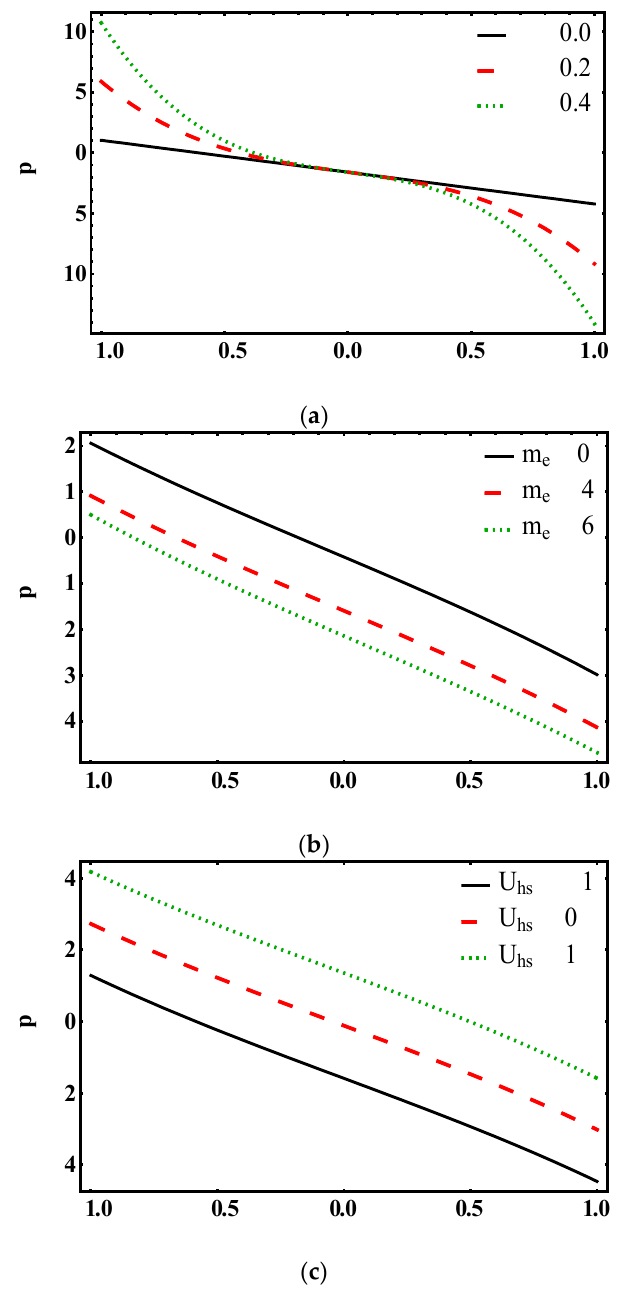
Figure 4. Pressure rise ∆ P λ profile for ( a ) . Г ( b ) . m e ( c ) . U hs , while other parameters are Г = 0.1, ε = 0.258, m e = 2, U = −1 .